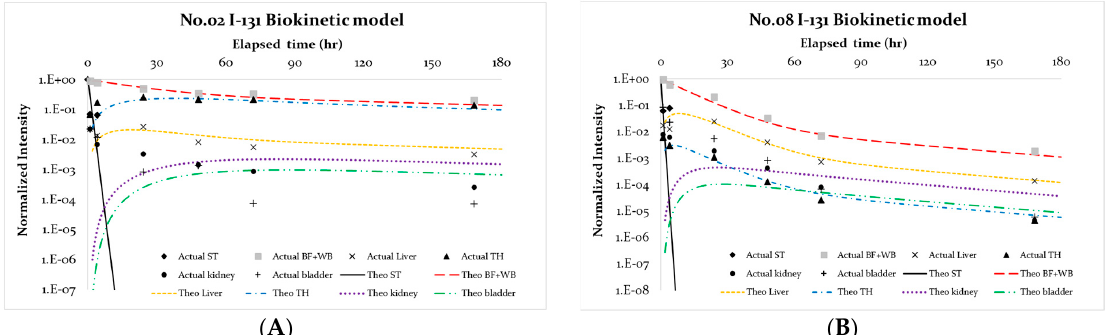
Figure 4. Cases 2 and 8 with the zero initial values for kidney and bladder; the outcome differs from the experimental data from in vivo gamma camera scanning. ( A ) Cases 2 and ( B ) case 8 with the zero initial values for kidney and bladder; the outcome differs from the experi-mental data from in vivo gamma camera scanning.